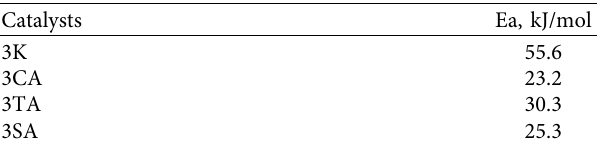
Table 5. For all catalysts, the FAME formation percentage